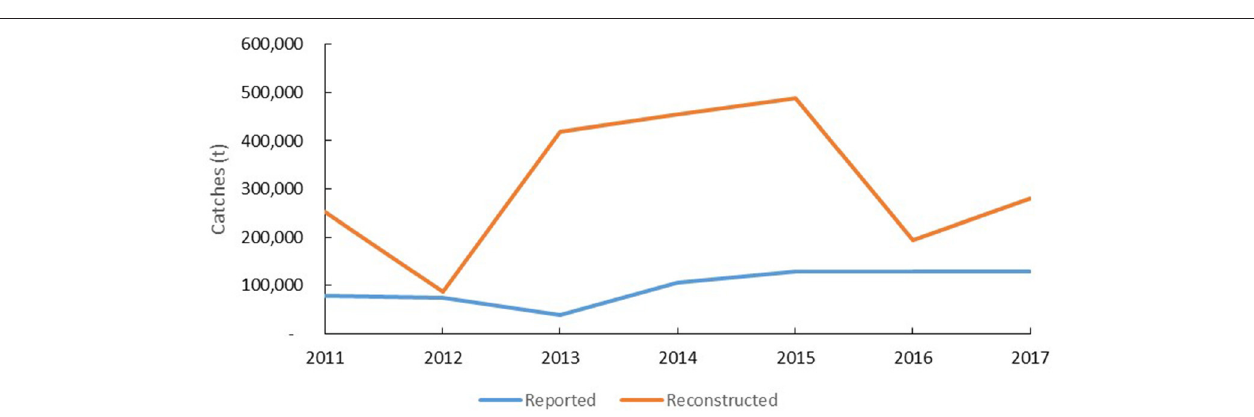
FIGURE 3 | Industrial legal catches of Guinea Bissau as compared to officially reported data to the government of Guinea Bissau, 2011–2017.